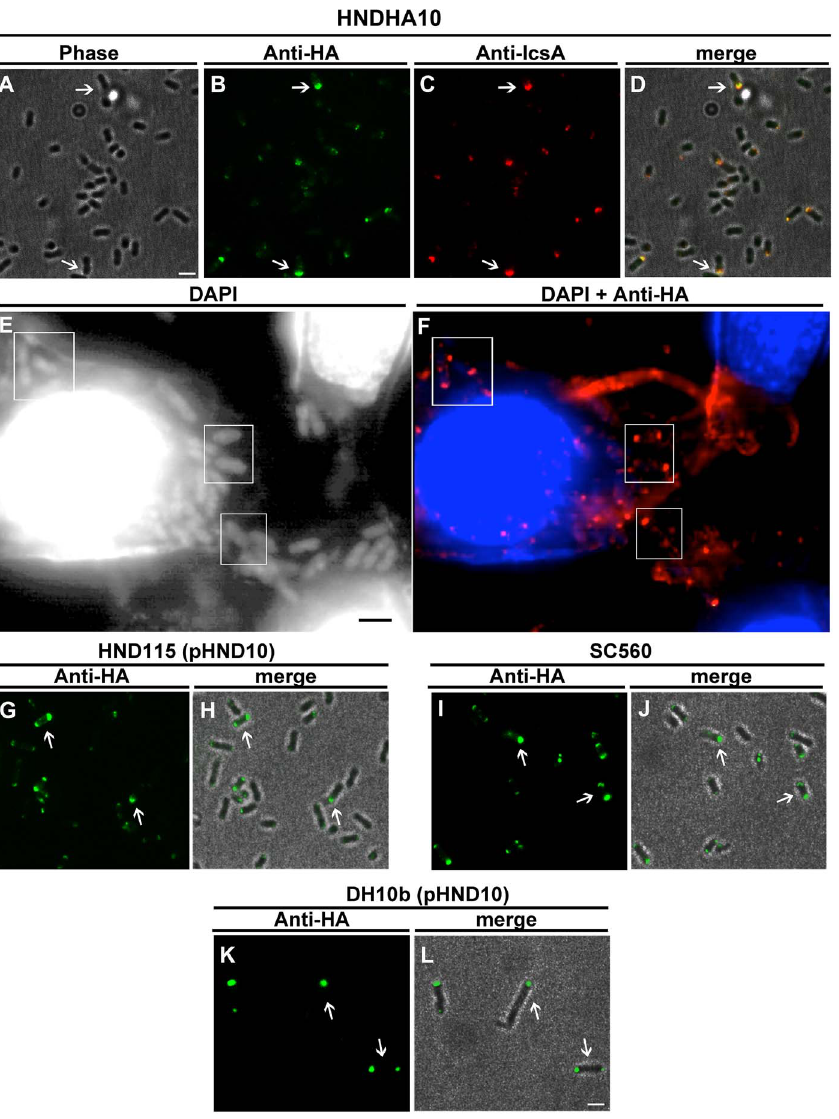
Figure 2. PhoN2-HA localizes at the poles of both exponentially-growing S.flexneri and of E.coli K-12 strains. Images are representative of phase-contrast, DAPI, anti-HA, anti-IcsA, and the merged fields. Panels A–D, HNDHA10 phoN2 ::HA. Panel A, phase-contrast; Panel B, bacteria stained with anti-HA (green); Panel C, bacteria stained with anti-IcsA (red); Panel D, overlay of fluorescence of panels A–C. Panels E–F, semi-confluent monolayers of HeLa cells were infected with exponentially-growing HNDHA10 phoN2 ::HA. After 2 h of infection, HeLa cells and bacteria inside cells were stained with DAPI (panel E) and with DAPI (blue) and anti-HA (red) (panel F, overlay of fluorescence). Squares indicate subpopulation of bacteria displaying polarly localized PhoN2-HA. Panels G–L, immunofluorescent staining of the D phoN2 strain HND115, of the D icsA strain SC560 and of the E. coli K-12 strain DH10b (Table S1) complemented with plasmid pHND10 (panels G, I and K, anti-HA staining, green; panels H, J and L, overlay of the immunofluorescent images with the corresponding phase-contrast images). Bacteria shown in panels G–L were incubated in the presence of 0.016% of L-arabinose to induce phoN2 ::HA expression. No specific fluorescence signals were evidenced when bacteria were grown in the absence of the inducer (data not shown). Experiments were repeated at least three times and images are representative. Bars =2 m m. doi:10.1371/journal.pone.0090230.g002 To get further insight on the polar localization of PhoN2 and to showed that 0.016% of L-arabinose was the concentration that evaluate possible PhoN2-IcsA interactions, recombinant plasmid induced a level of phoN2 ::HA expression which more closely pHND10, a pBAD28-based recombinant plasmid carrying the resembled that occurring in the wild-type strain grown in the phoN2 ::HA fusion under the control of an L-arabinose-inducible presence of the Congo red dye, i.e. in conditions of phoN2 MxiE-up- promoter, was generated and introduced into HND115 and SC560, regulated transcription (Figure S1). Accordingly, the concentration D phoN2 and D icsA mutant derivatives of wild-type, respectively of 0.016% of L-arabinose was routinely used to induce phoN2 ::HA (Table S1). To induce phoN2 ::HA expression in HND115 expression throughout the all study. As expected, the D phoN2 (pHND10) at wild-type levels, Real-Time PCR analysis was mutant harboring pHND10, grown in the presence or not of performed using a wide range of L-arabinose concentrations (from 0.016% of L-arabinose, was as efficient as the wild-type strain in 0.002 to 0.2%) and using the primer pair listed in Table S2. Results invading HeLa cell monolayers, while wild-type plaques were